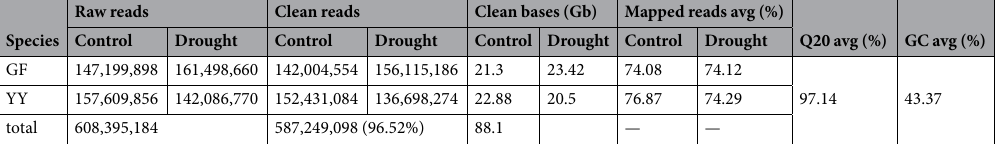
Table 1. Details of the raw data and clean data of twelve transcriptomes from drought-tolerant Corchorus olitorius (GF) and drought-sensitive C. capsularis (YY).